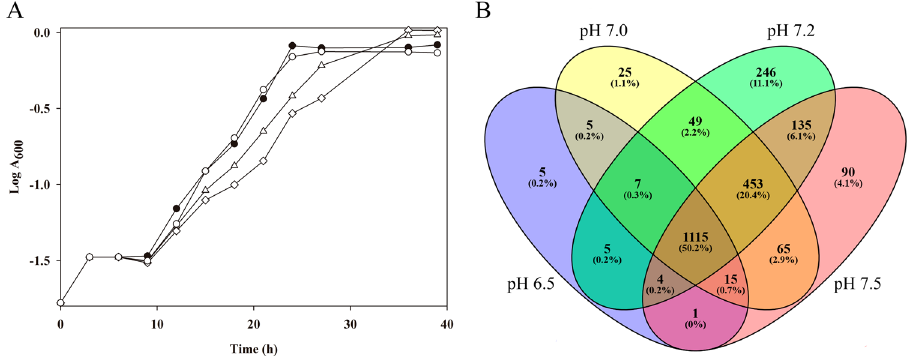
Figure 1. Effect of pH on growth and proteome of P. denitrifcans PD1222. Growth curves of P. denitrificans in mineral media with nitrate (30 mM) as nitrogen and energy source. Black circles, growth at pH 7.2; triangles, growth at pH 7.0; diamonds, growth at pH 6.5; white circles, growth at pH 7.5 ( A ). Proteomic analysis of the P. denitrificans cells grown at different pHs: blue, pH 6.5; yellow, pH 7.0; green, pH 7.2; red, pH 7.5. Number of identified proteins in each pH condition is indicated, and the percentage with respect to the total identified protein in all conditions is given in brackets ( B ). The Sigmaplot software for Windows version 11.0 (http:// www. sigma plot. co. uk) was used to create the growth curves and the Venny software version 2.1 (https:// bioin fogp. cnb. csic. es/ tools/ venny/) was used to design the